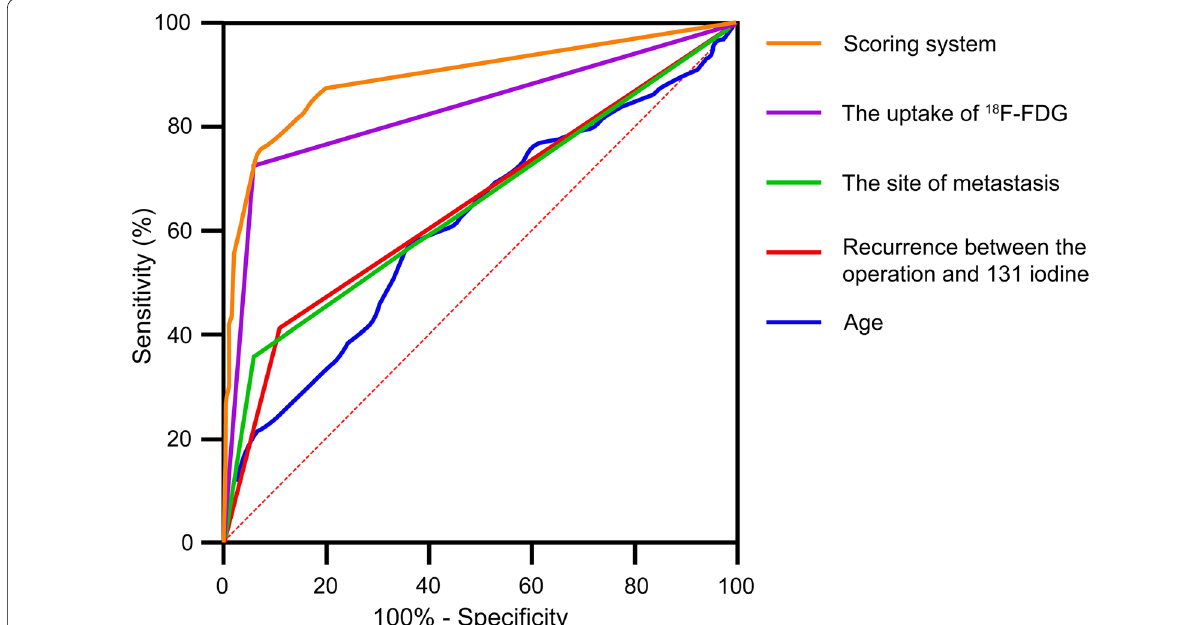
Fig. 6 The AUC of the scoring system was larger than that of the other independent predictors. It had a higher discrimination power than other single independent predictors (largest AUC 0.833). 18 F-FDG, 18 F-fluorodeoxyglucose; AUC, area under the =